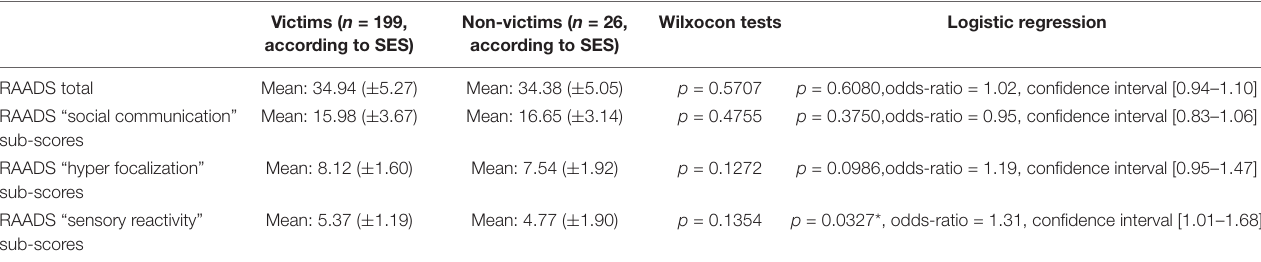
TABLE 8 | Ritvo Autism and Asperger Diagnostic Scale score as a risk for victimization.